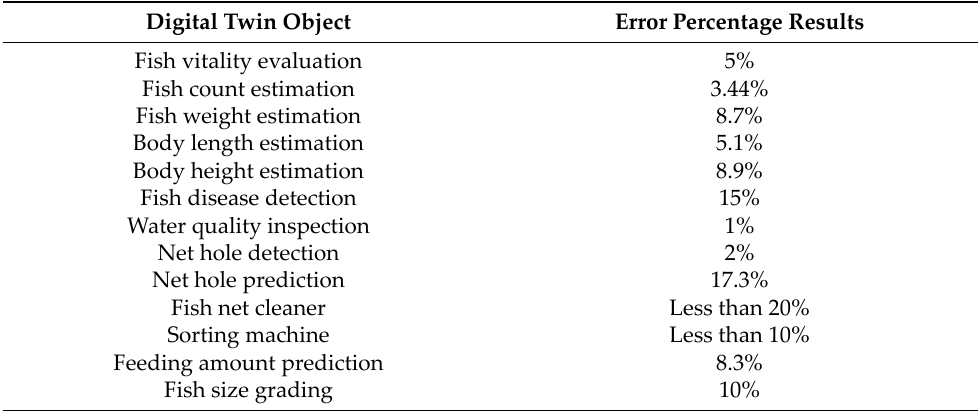
Table 14. Evaluation results of various digital twin objects.